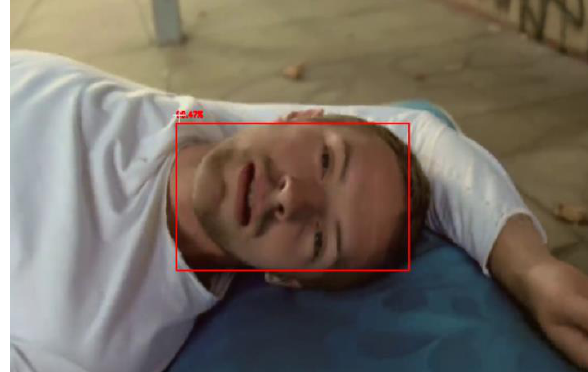
Figure 9. Result showing face detection in video using our proposed model